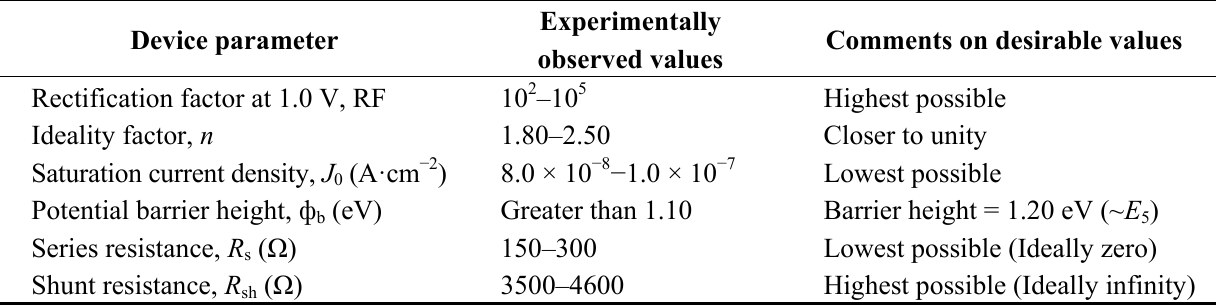
Table 1. Typical parameter ranges observed for electrodeposited CdS/CdTe solar cells under dark condition and comments on desired values.